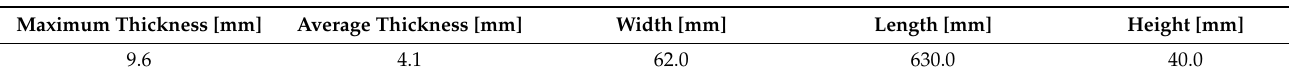
Figure 3. Plastic part main dimensions. Table 1. Plastic part main dimensions.